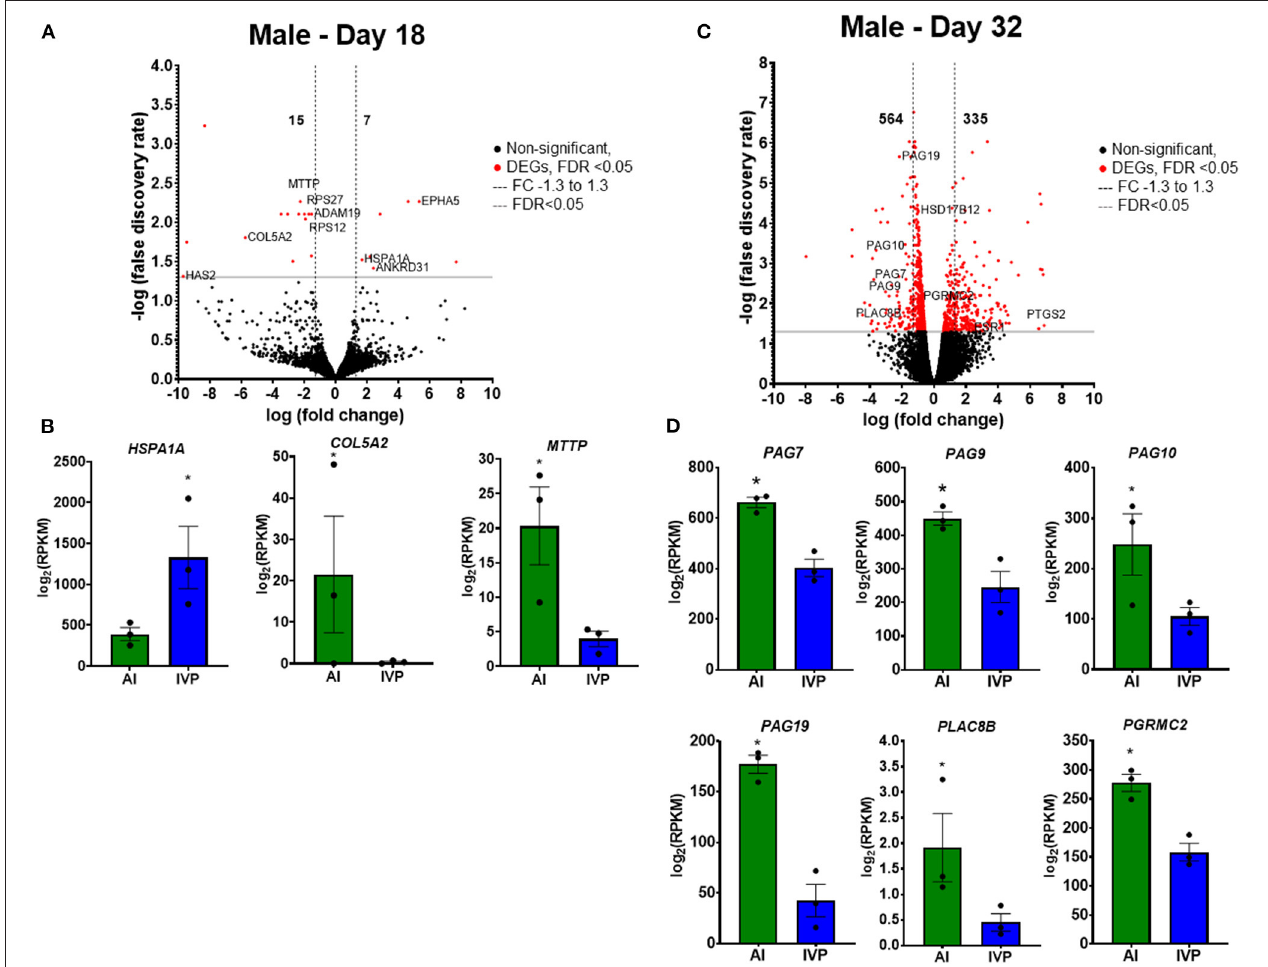
FIGURE 6 | Differentially expressed genes (DEGs) of the male conceptuses on day 18 and placentas on day 32. (A) Volcano plot representing the number of DEGs comparing IVP vs AI on day 18 conceptuses. Black dots are not significant (FDR > 0.05), Red dots are significant (FDR < 0.05), Gray line at FDR = 0.05, Black dashed lines delimit FC − 1.3 to 1.3. Some representative DEGs of important roles during this time period, are shown in (B) . (C) Volcano plot representing the number of DEGs comparing IVP vs AI on day 32 conceptuses. Black dots are not significant (FDR > 0.05), Red dots are significant (FDR < 0.05), Gray line at FDR = 0.05, Black dashed lines delimit FC − 1.3 to 1.3. Some representative DEGs of important roles during this time period are shown in (D) *FDR < 0.05. AI, artificial insemination; IVP, in vitro produced